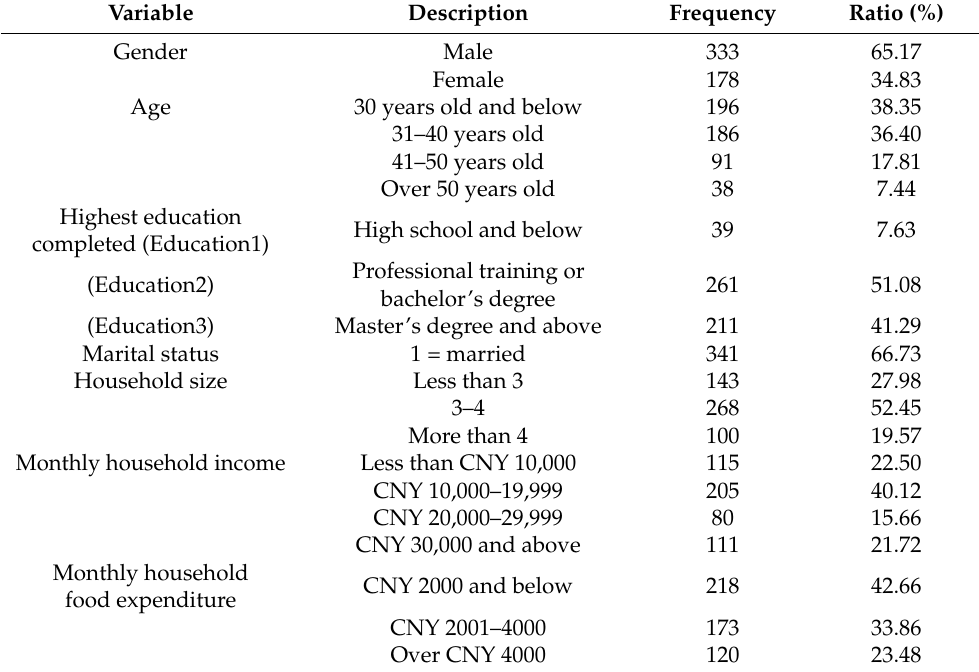
Table 1. Basic information of the